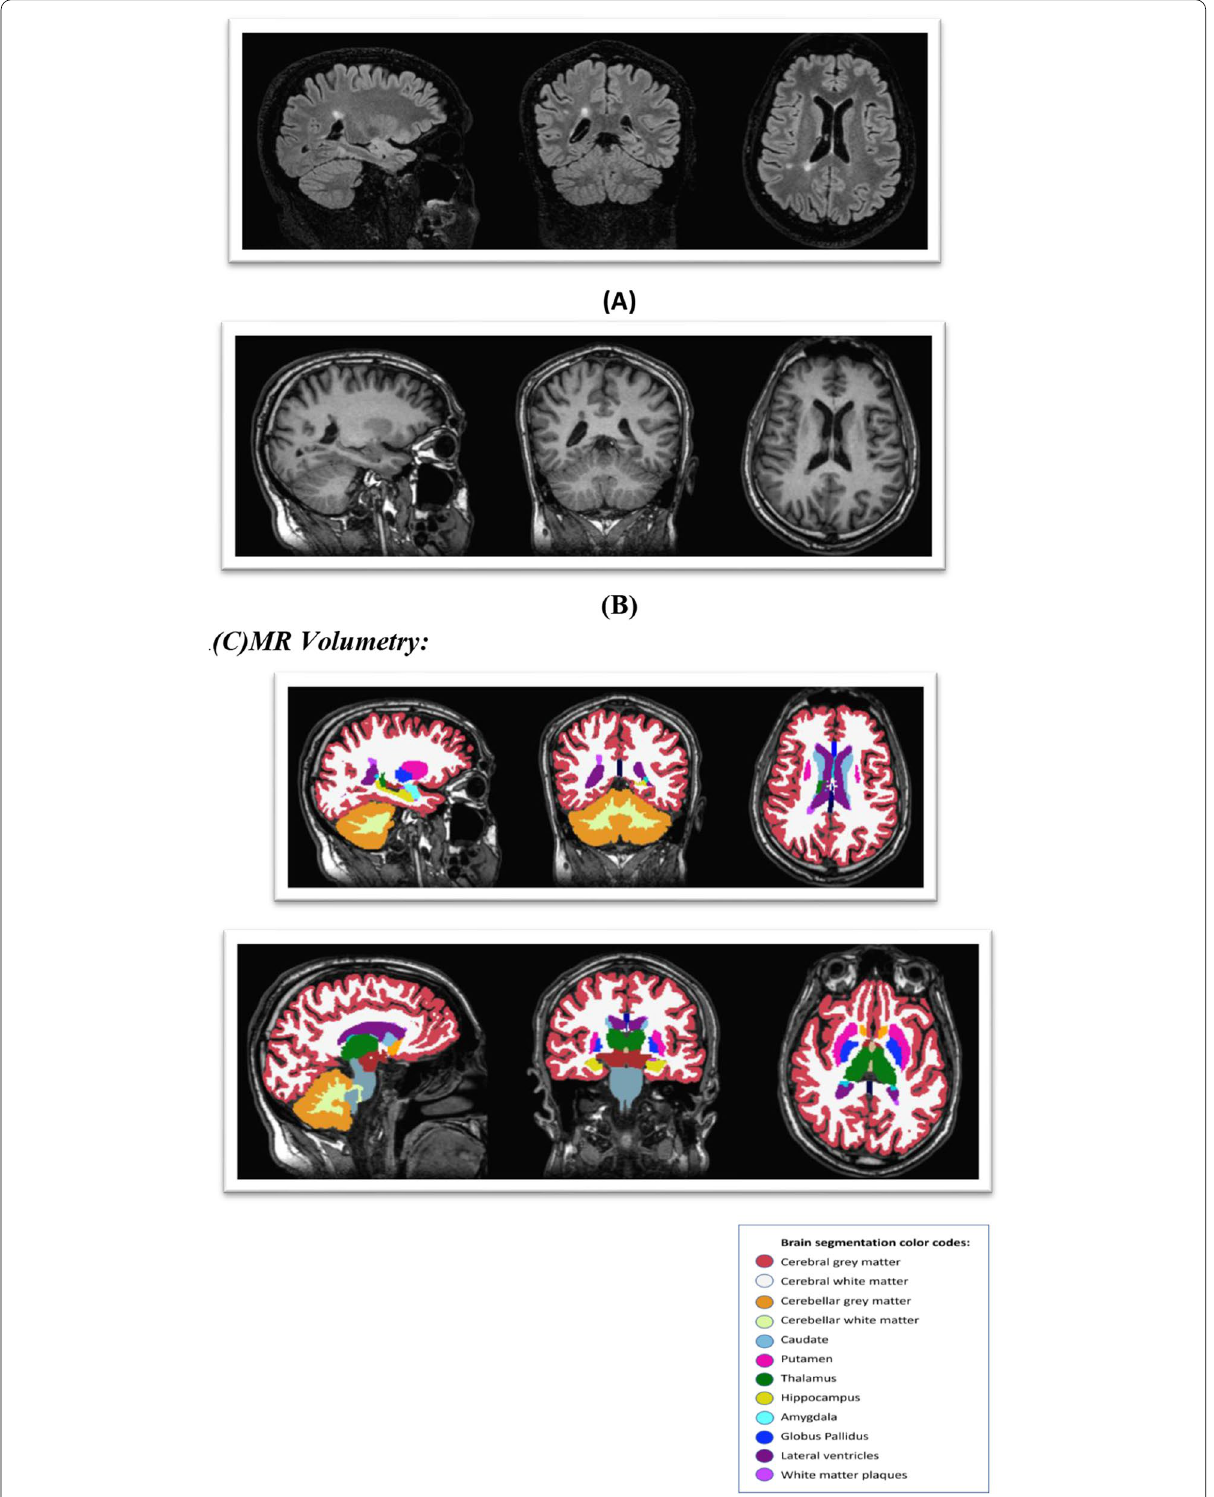
Fig. 13 32 year old male diagnosed with MS 9 years ago with EDSS (4) with cognitive impairment. ( A ) 3D FLAIR images showing multiple foci and patchy areas of high signal intensity implicating the peri ventricular and juxta cortical white matter. ( B ) 3D T1 images showing multiple foci and patchy areas of slightly low signal intensity implicating the peri ventricular and juxta cortical white matter. ( C ) MR